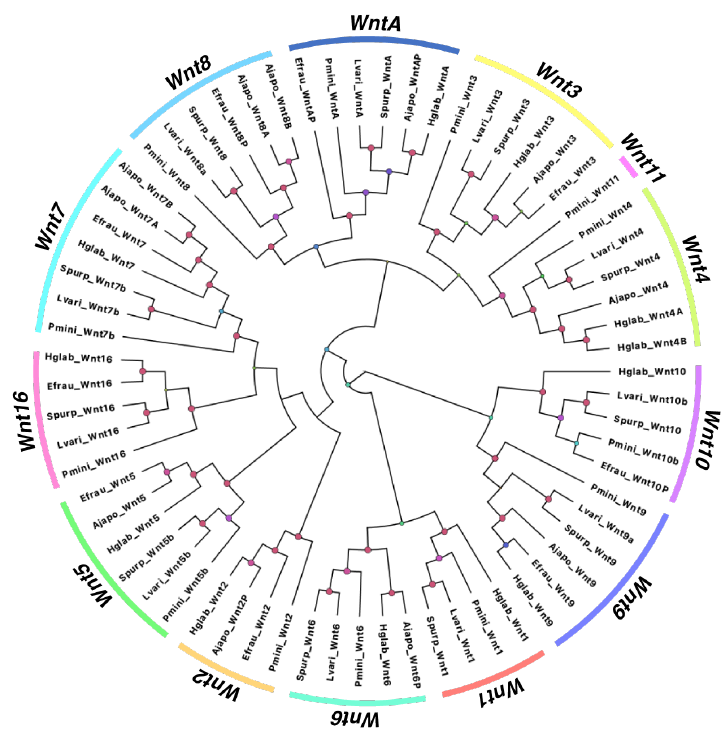
Figure 3. Phylogenetic analysis of Wnt from distinct Echinoderm species. Gene tree of all Wnt genes identified in H. glaberrima (Hglab), along with those deposited in NCBI or Echinobase for S. purpuratus (Spur), L. variegatus (Lvari), P. miniata (Pmini), A. japonicus (Ajapo), and E. fraudatrix (Efrau). For all partial sequences, a letter P was added to its label; all other letters are based on the gene name shown in NCBI. The size and color of circles in nodes are dependent on their bootstrap value. Nodes with bootstrap values over 95 are shown in pink.